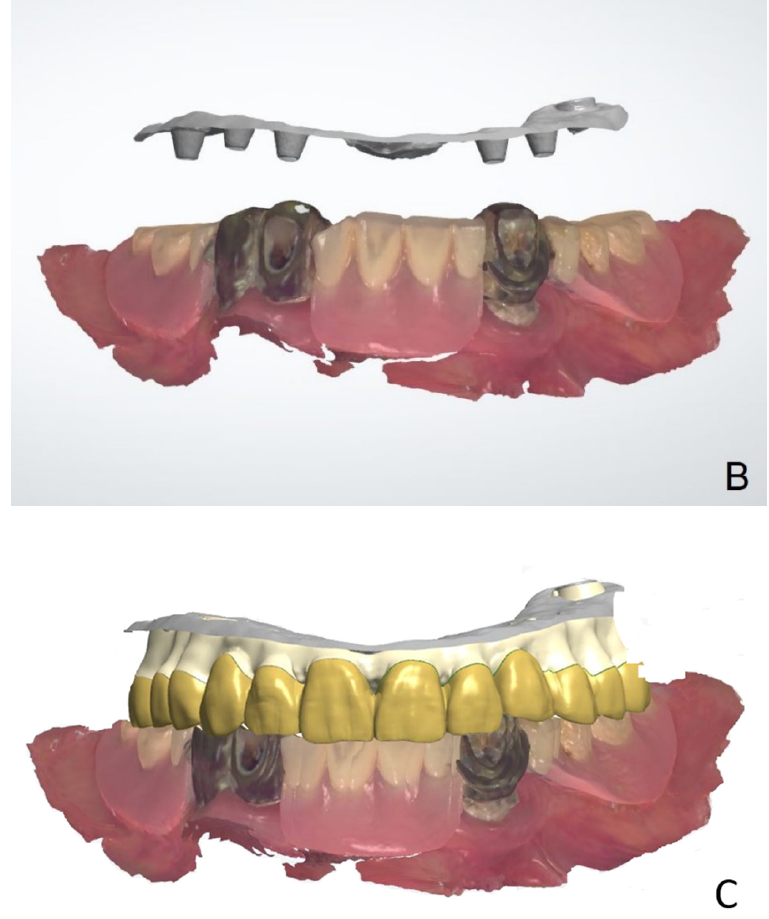
Figure 7. ( A ) Scan of the interim prosthesis. ( B ) Digital model of the cylinder cap and interim prosthesis base with the opposing teeth mounted at the occlusal vertical dimension. ( C ) Virtual metal framework and crown designed by using the virtual design software.